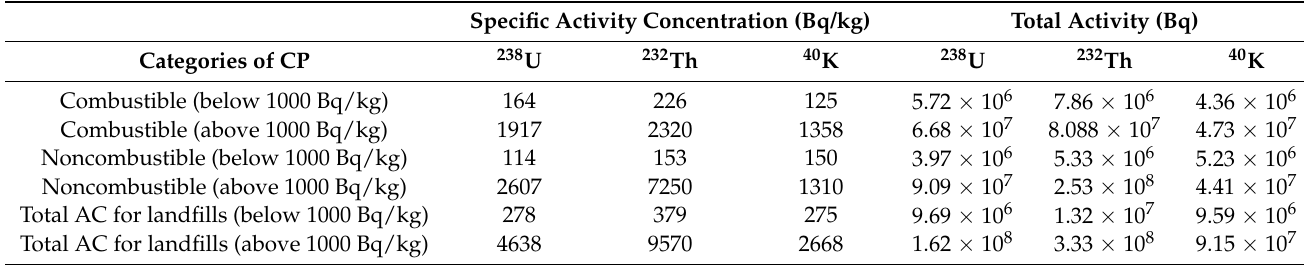
Table 1. 95% confidence interval for the total activity concentration